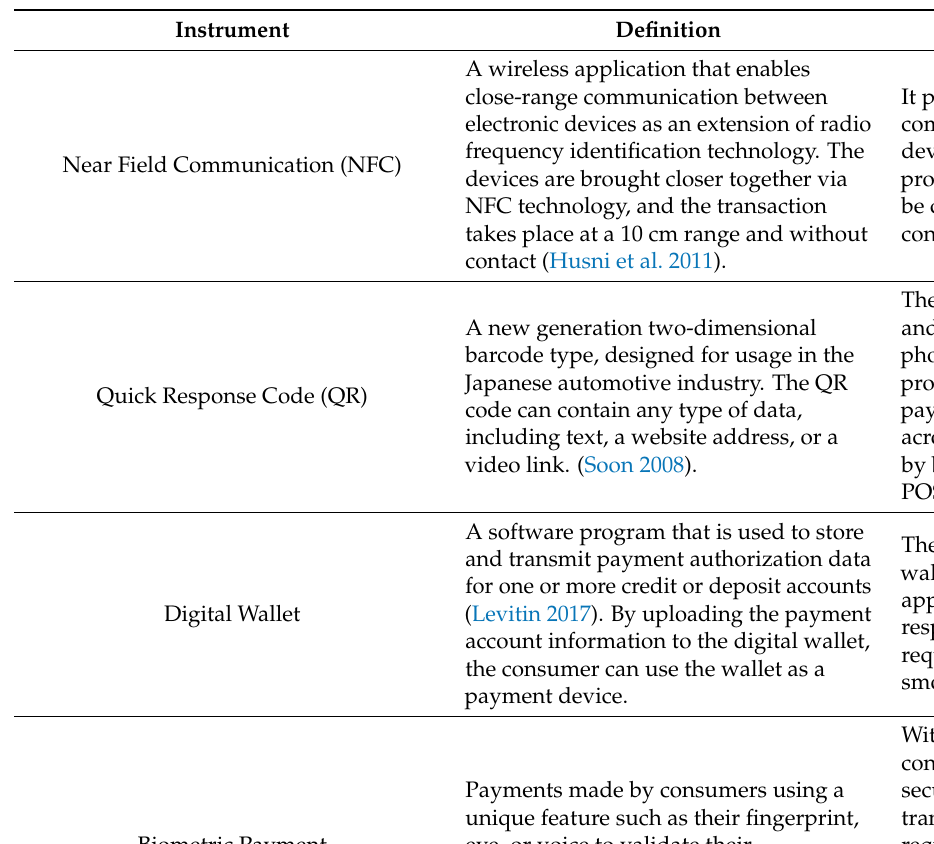
Table 1. Next-Generation Payment